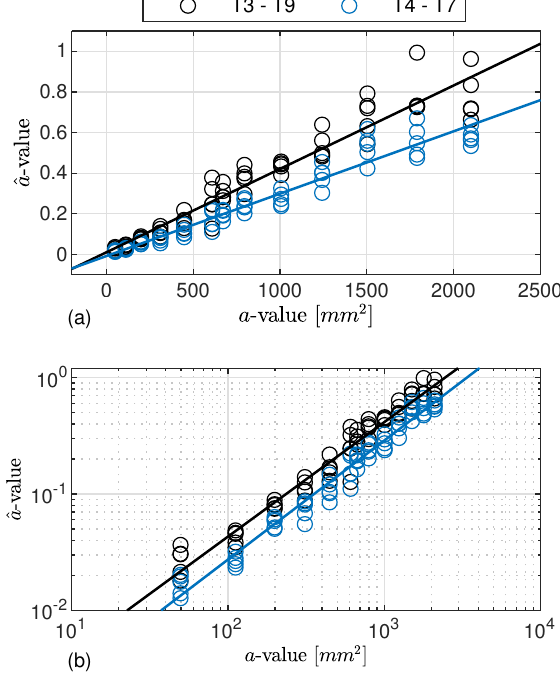
Figure 8. ˆ a vs. a regression analysis. Data samples related to damage D1 and paths T3–T9 and T4–T7. The corresponding linear trend is established using lin − lin ( a ) and log − log ( b )